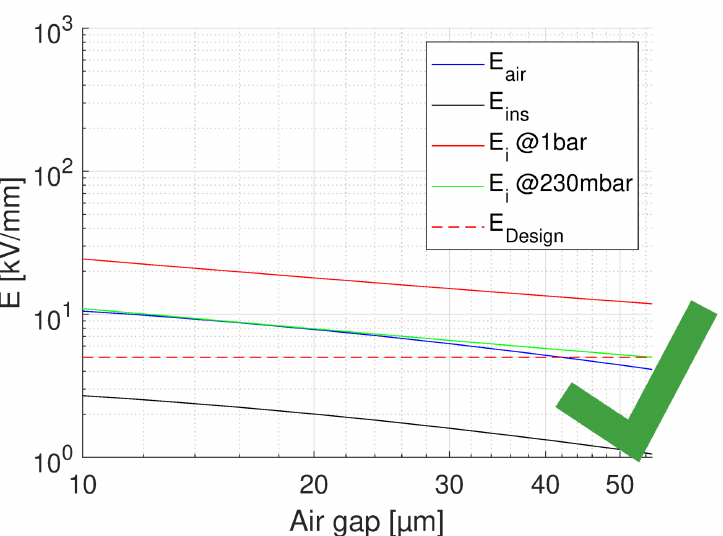
Figure 11. Feasibility plot for the design of turn insulation, with the insulation thickness (H1 = 55 µ m) providing no PD for any air gap and considered pressure range. Maximum voltage drop between turns 227 V (benign test conditions, Table 1). The x axis reports the air gap